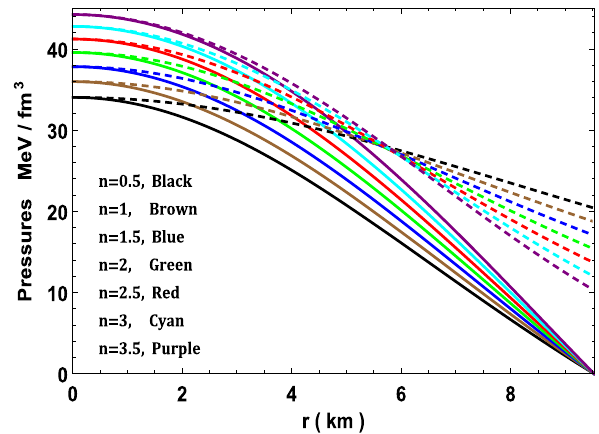
Fig. 3 Variation of pressure with radial coordinate r for 4U 1608-52 ( M = 1 . 74 M (cid:9) , R = 9 . 528 km) by taking a = 0 . 001 km − 2 and β = 0 . 01